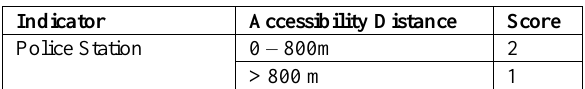
Table 5: The radius distance accessibility between residential housing and health indicator